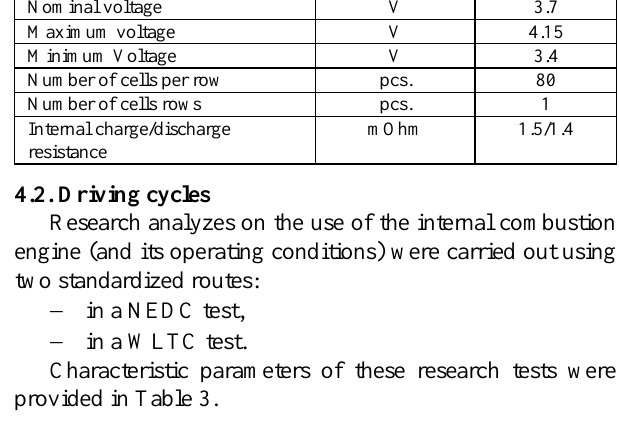
Table 1. Parameters characterizing the test vehicle with the internal com- bustion engine Parameter Unit